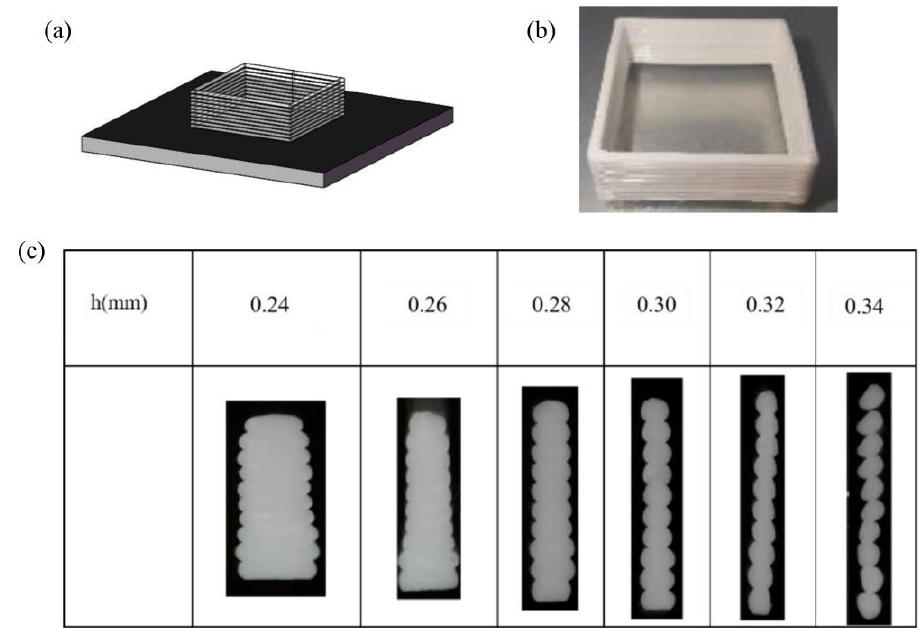
Figure 6. ( a ) Model diagram; ( b ) physical photos; ( c ) cross-sectional